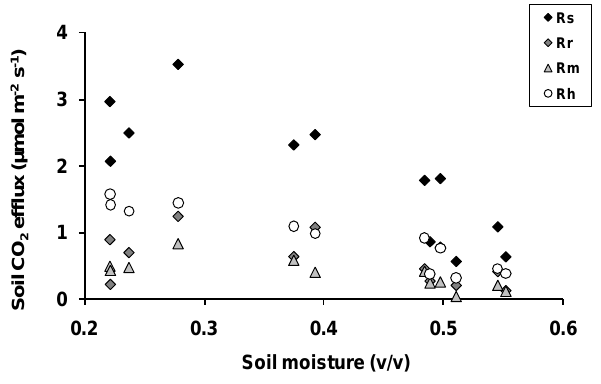
Fig. 6. Monthly average soil respiration ( R s ) and its components, i.e. root ( R r ) , mycorrhizal hyphae ( R m ) and heterotrophic ( R h ) res- piration at the Straits Enclosure, Alice Holt forest during 2010, against the mean volumetric soil moisture content ( v / v ) measured at 6cm mineral soil depth in the individual treatments.